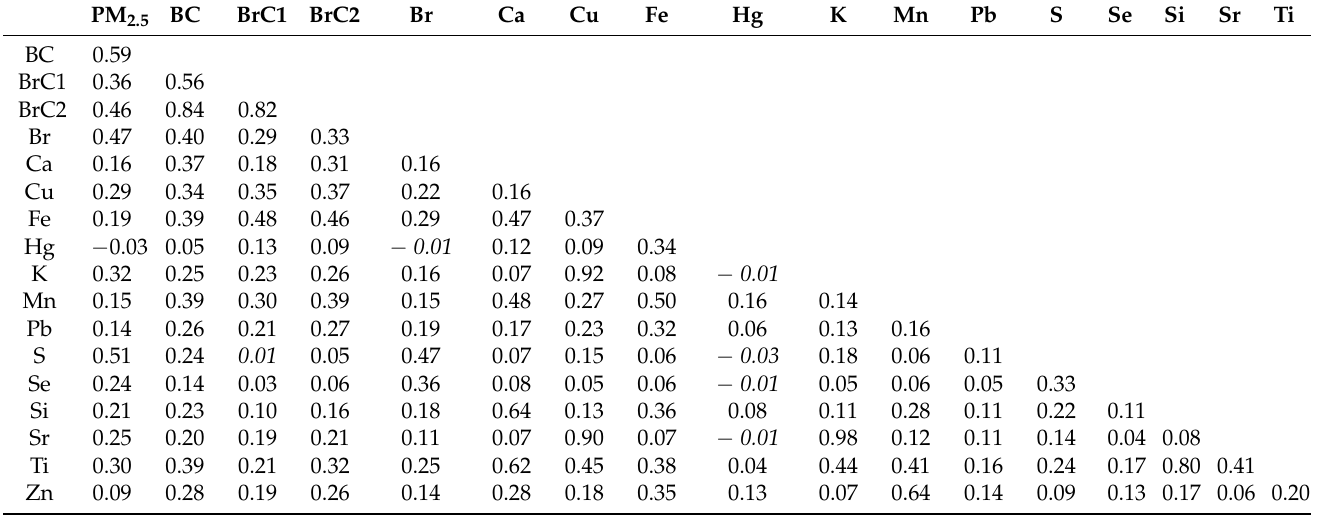
Table 2. Correlation coefficients among PM 2.5 , BC, BrCs, and PM 2.5 -bound elements. Italic values indicate p -value ≥